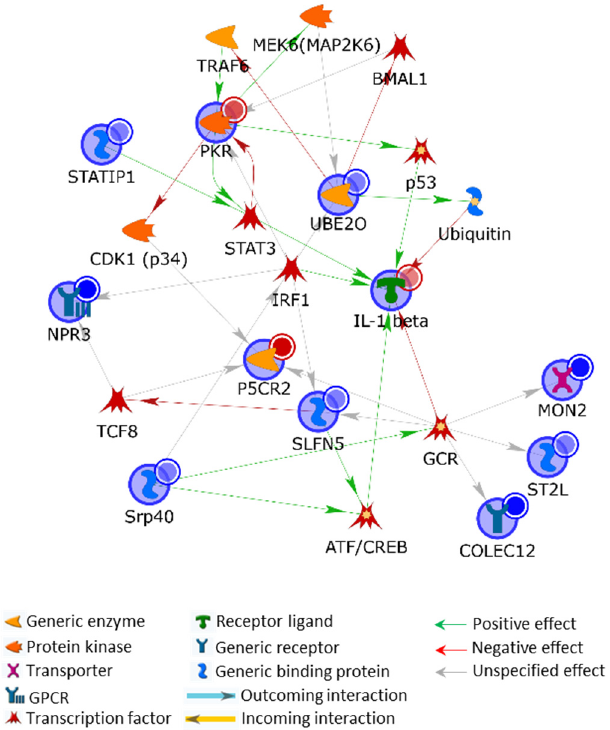
Figure 7. MetaCore SPN built by processing significant HSMC proteins deregulated by 48 h of CSC-treatment and identified using MS or detected using WB. Experimental factors, circled in blue, are cross-linked by expanding protein interactions to other factors, not present in the processed list but supported by the MetaCore database, that are needed to functionally correlate experimental protein di ff erences that do not directly interact. Only TMEM43 did not enter into the SPN. Red and blue bubbles indicate the up- and downregulation, respectively, of the experimental factors in CSC-treated HSMCs.